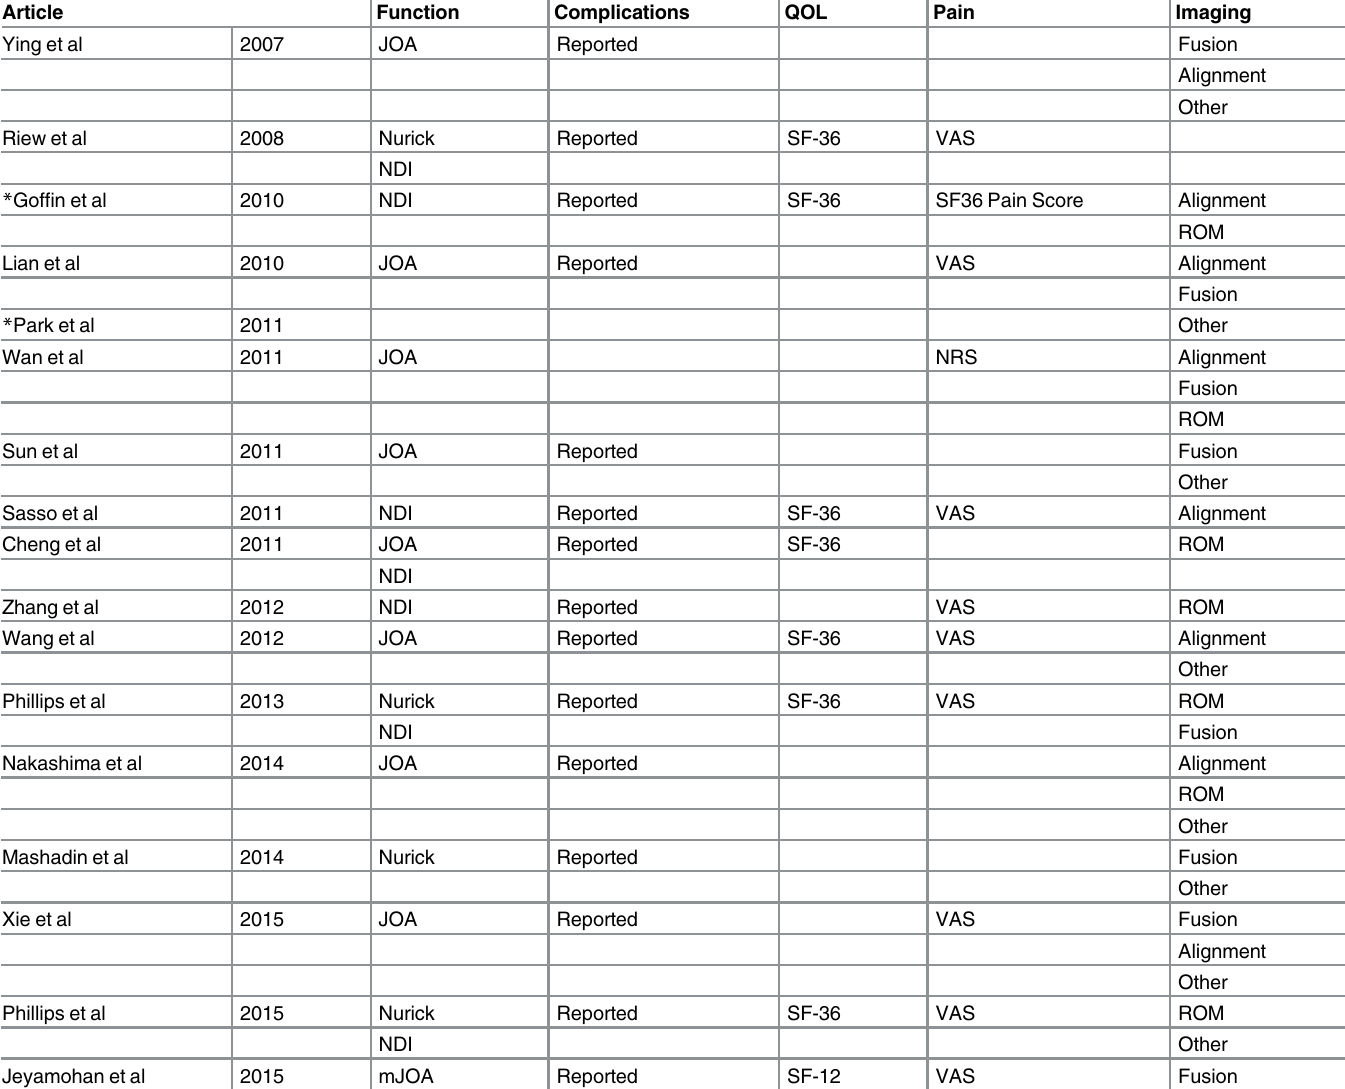
Table 2. Outcome domains reported by Randomised Controlled Trials.